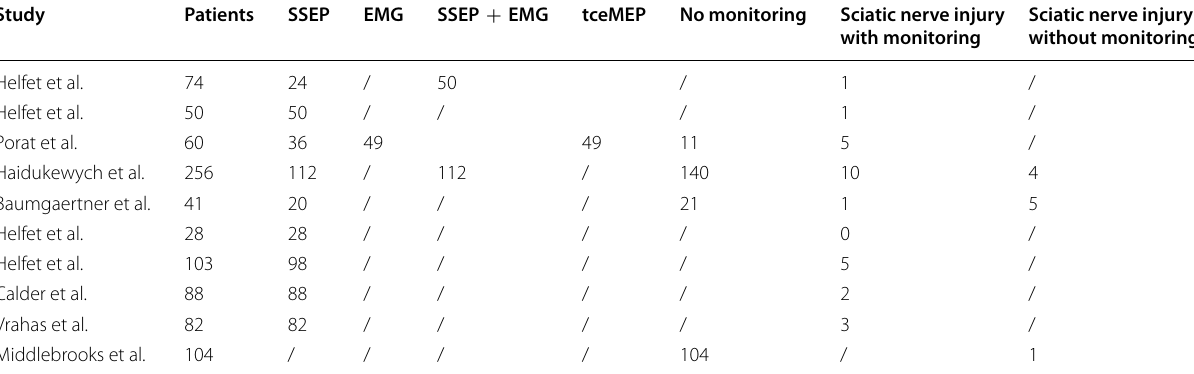
Table 3 Acetabular and pelvic fractures surgery